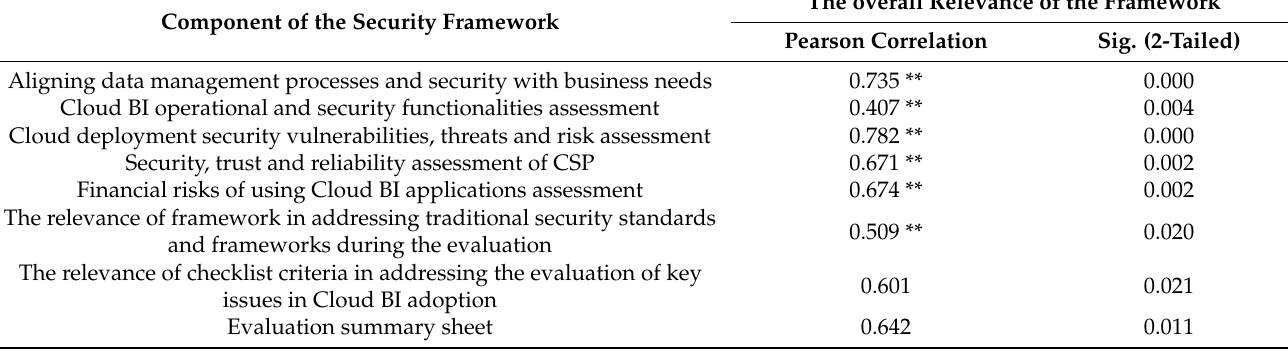
Table 6. Correlation results for relevance